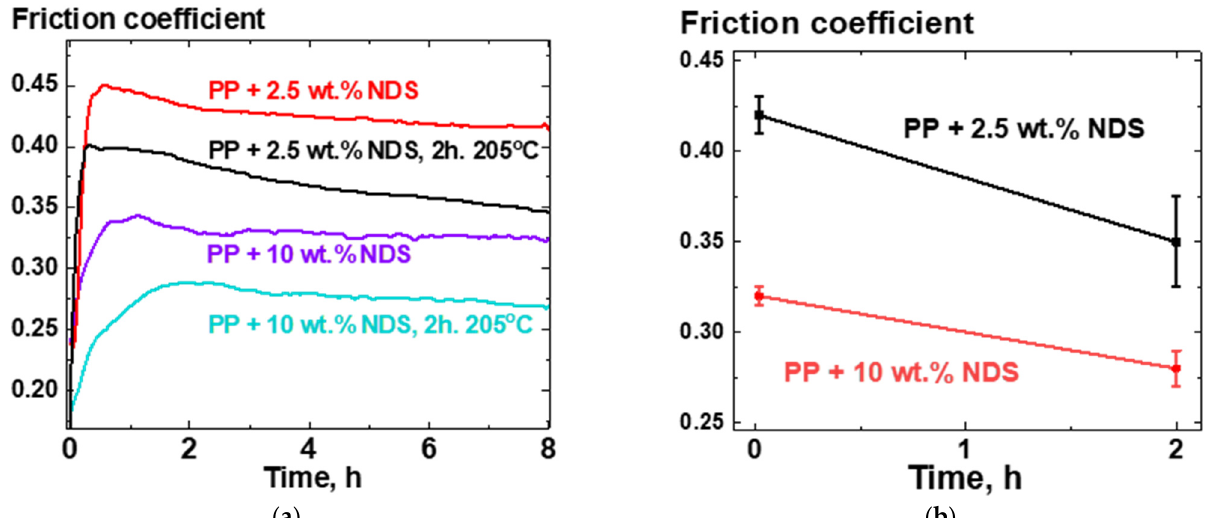
Figure 7. ( a )—Friction coefficient versus time of a tribological test (steel pin on a rotating composite disk) curves, averaged over six independent test results for each curve, for composites PP + 2.5 wt.% NDS and PP + 10 wt.% NDS before and after keeping the composites for 2 h in a melted state at 205 °C; ( b )—friction coefficient versus time of heat treatment at 205 °C for composites PP + 2.5 wt.% NDS and PP + 10 wt.% NDS.